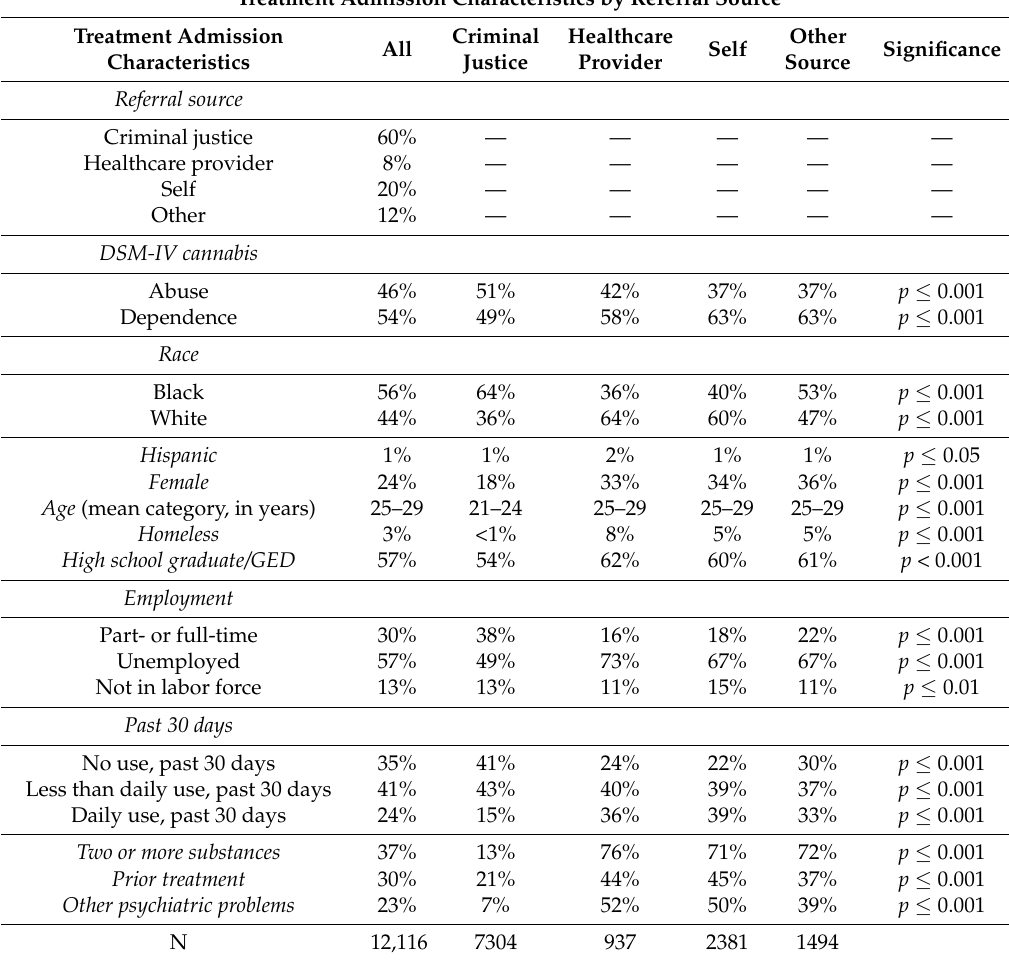
Table 2. Characteristics of treatment admissions to outpatient services for cannabis dependence or cannabis abuse by referral source, North Carolina